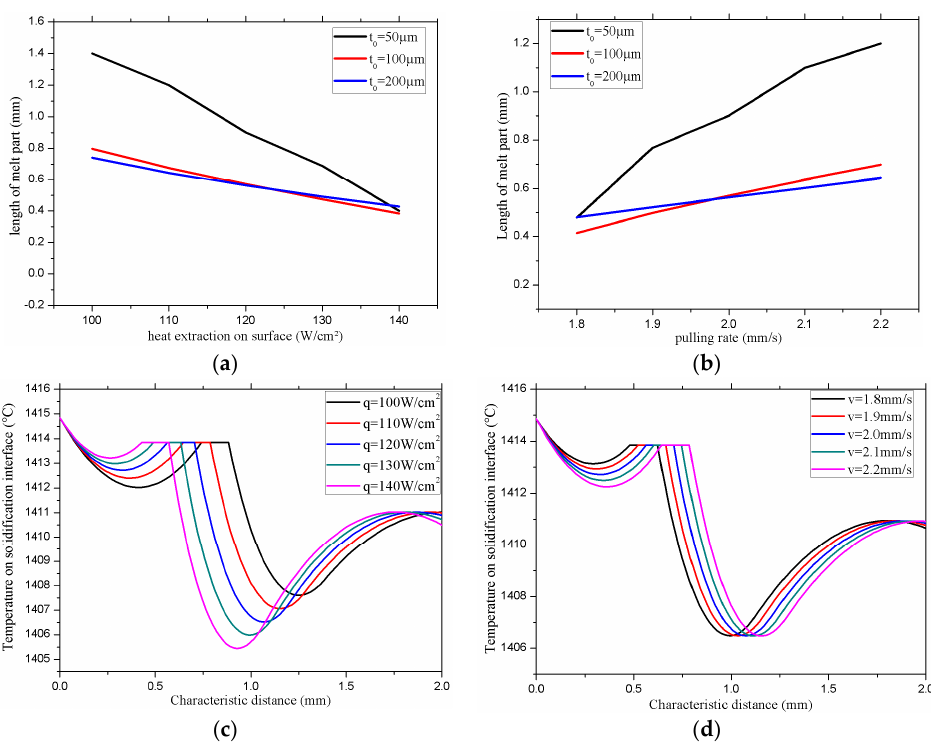
Figure 7. For different initial thicknesses, the change of solidification position with ( a ) heat extraction on surface, ( b ) pulling velocity. The change of thermal profile with ( c ) heat extraction and ( d ) pulling velocity ( t 0 = 200 µ